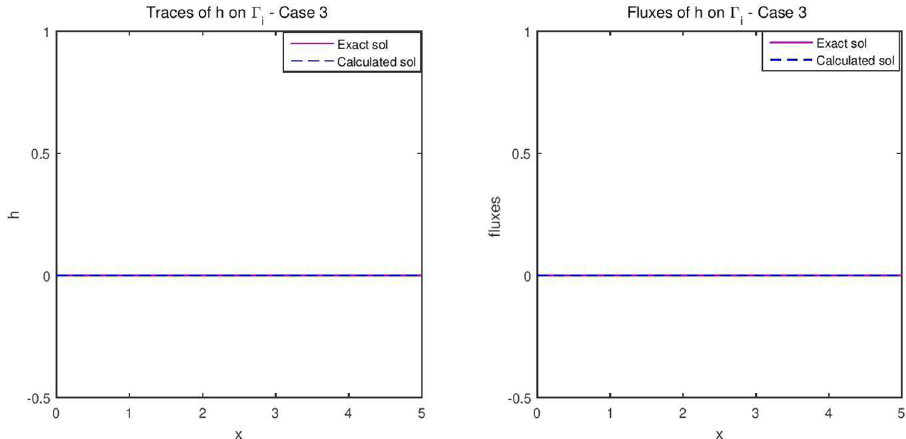
Figure 8. The reconstructed flow—Case 3.